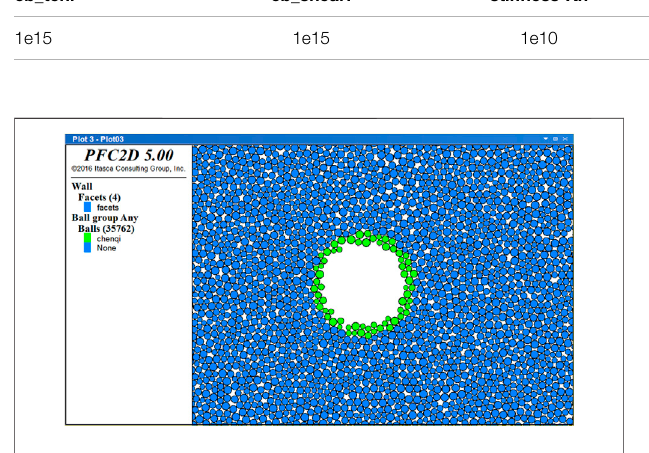
FIGURE 1 | 2D PFC model of